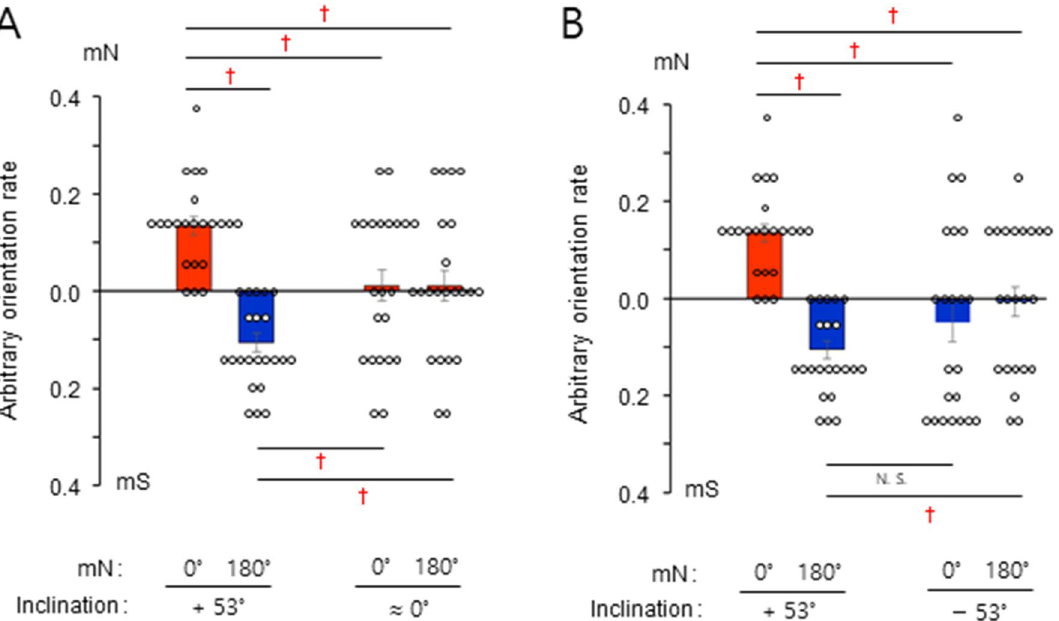
Figure 4. A non-canonical magnetic inclination compass in humans. Selected starved subjects were tested under different inclinations with full wavelength light. The Y axis represents arbitrary orientation rate toward true magnetic north (mN) or true magnetic south (mS). ( A ) Inclination ≈ 0° due to cancellation of the vertical component of the ambient GMF. ( B ) Inclination − 53° due to inversion of the vertical component. The data from the ambient inclination (+ 53°) in (a) and (b) are the same. †, significant; N. S., not significant by a percentile bootstrap analysis (see Appendixes S1 and S2); error bars, standard error of the mean (SEM). Subjects, n =